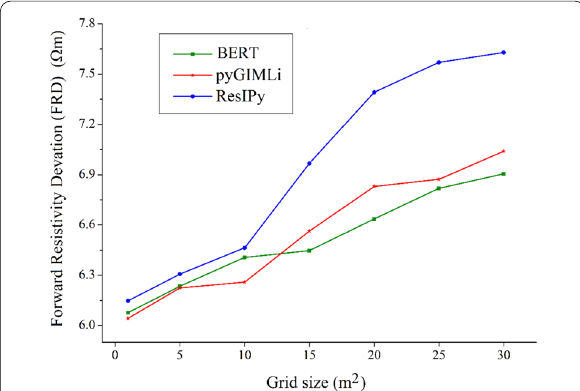
Fig. 6 Forward resistivity data variation among the pyGIMLi, BERT, and ResIPy freeware for different grid sizes. The grid size value indicates the maximum area of unstructured triangular mesh for forward resistivity